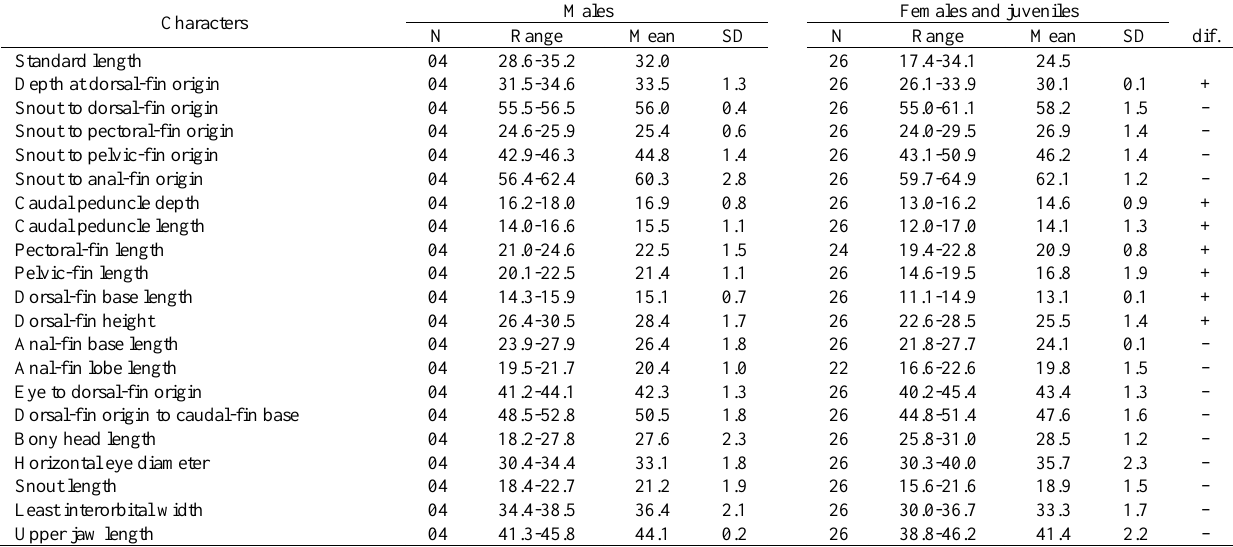
Table 5. Morphometrics of Glandulocauda caerulea . Standard length is expressed in mm; measurements through bony head length are percentages of standard length; the last four entries are percentages head length. A plus sign under the abbreviation dif indicates there is a significant statistical difference between the males and females in the particular character indicated. All specimens are from riacho dos Pardos, tributary of rio Canoinhas, Santa Catarina State, Brazil. MNRJ 5642. SD = Standard deviation.